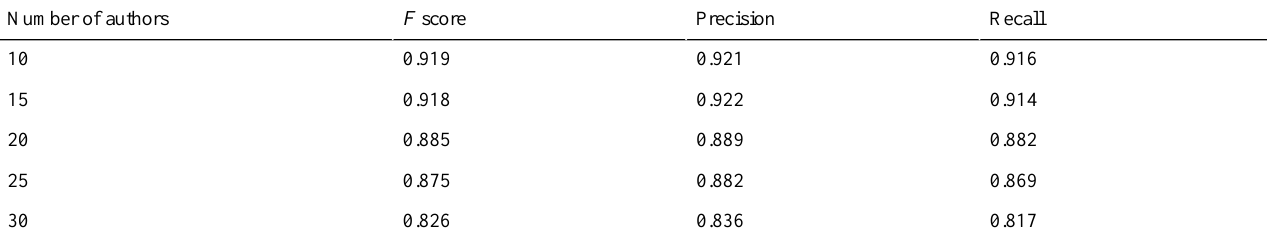
Table 6. Dependency of the accuracy of author detection task on candidate author number on the IVF Ages 35+